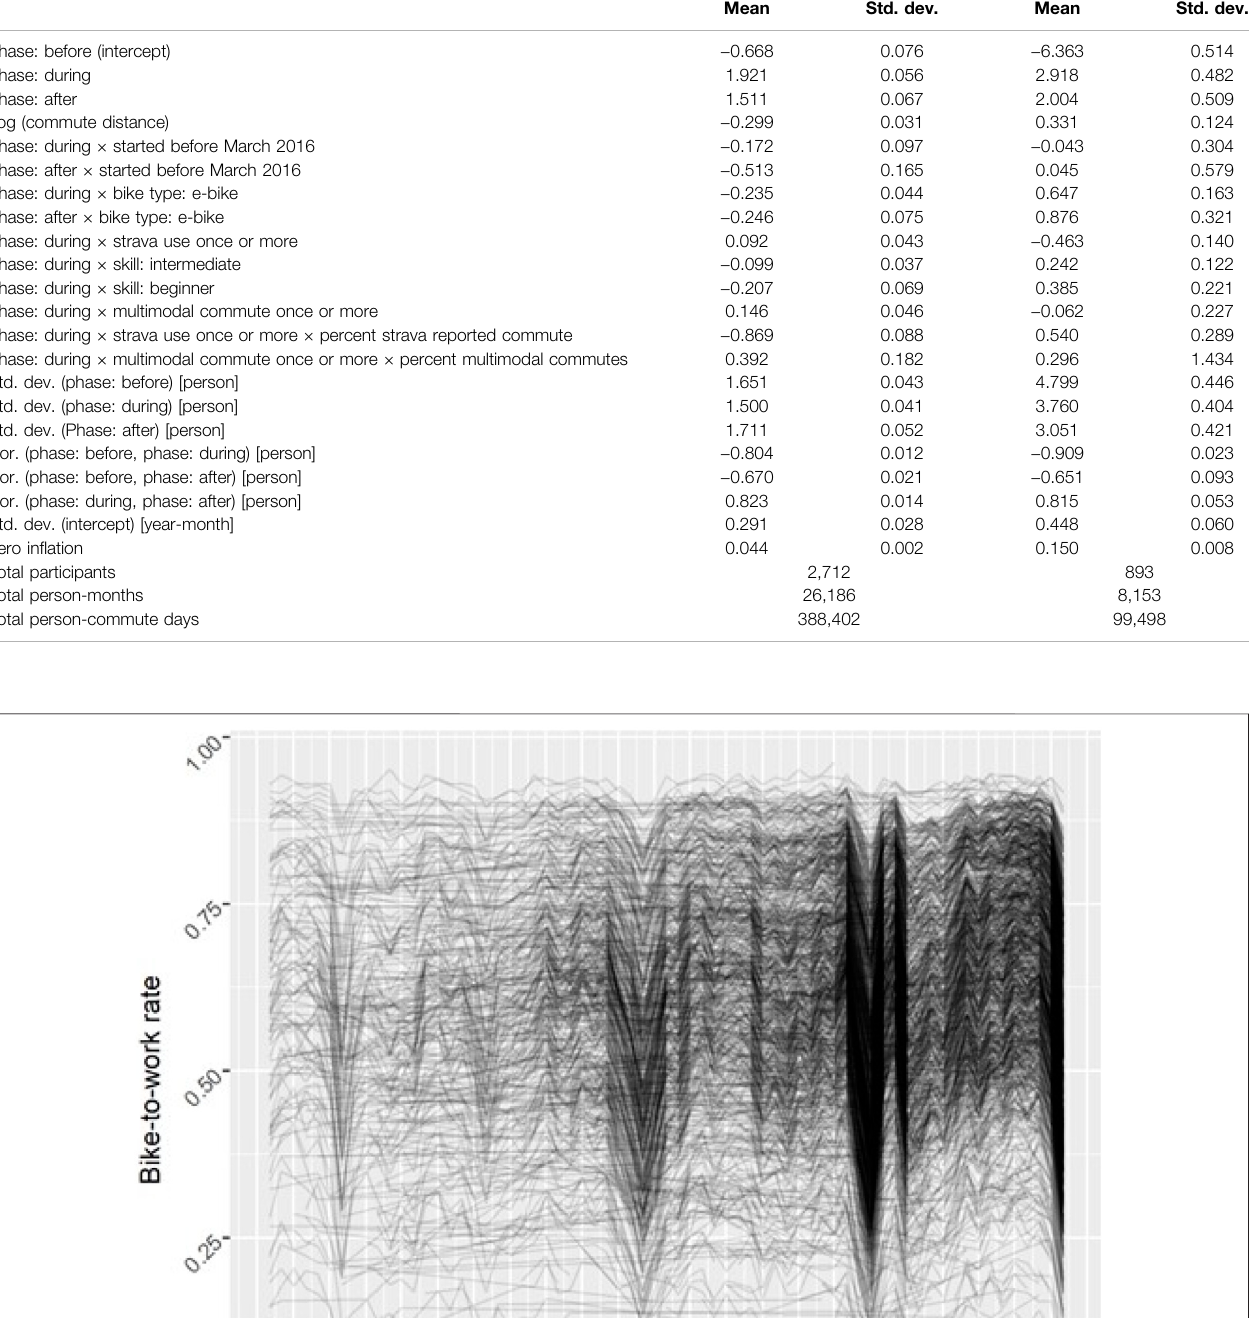
TABLE 2 | Zero in fl ated aggregate binomial bike- and SOV-to-work model summaries. Variables